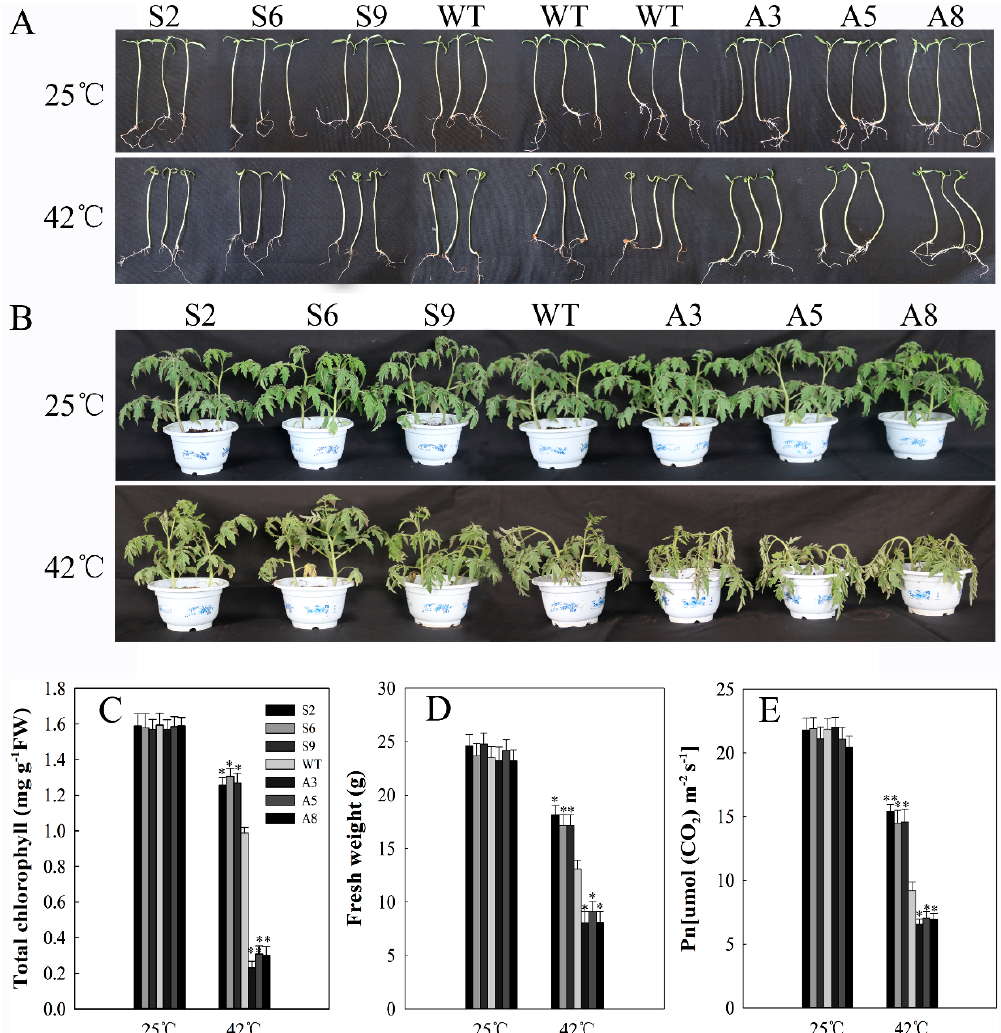
Figure 6. Heat tolerance of ten-day-old seedlings and six-week-old plants. ( A ) Phenotype of ten-day-old seedlings under 25 ◦ C and 42 ◦ C for two days; ( B ) phenotype of six-week-old plants under 25 ◦ C and 42 ◦ C for 24 h; ( C ) total chlorophyll content in grown plants; ( D ) fresh weight of grown plants. ( E ) net photosynthetic rate ( P n) in the grown plants. The mean values ± SD of at least three replicates are presented, and * p < 0.05 and ** p < 0.01 indicate significant differences compared with the control.